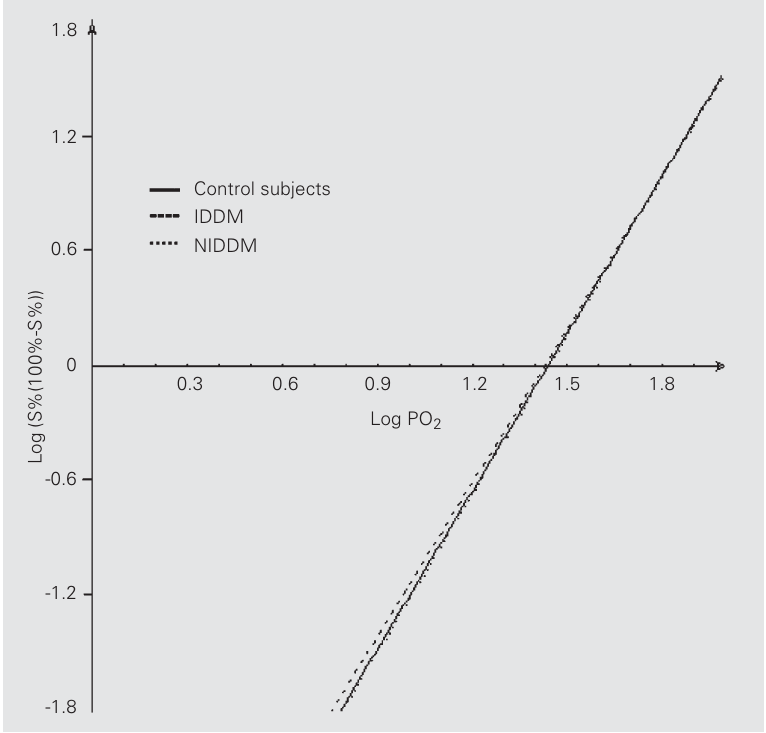
Figure 1. Hill plots for the oxygen dissociation curves for the three groups. See Table 2. IDDM, insulin-dependent diabetes mellitus; NIDDM, non-insulin-dependent diabetes melli- tus.